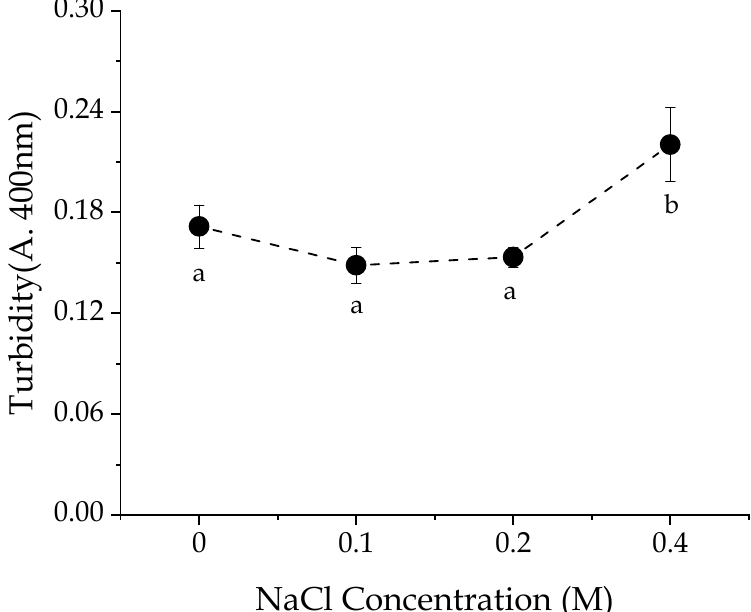
Figure 6. Turbidity of SPPH in different NaCl concentrations. Different letter indicates significant difference ( p < 0.05). Dash line is guide to the